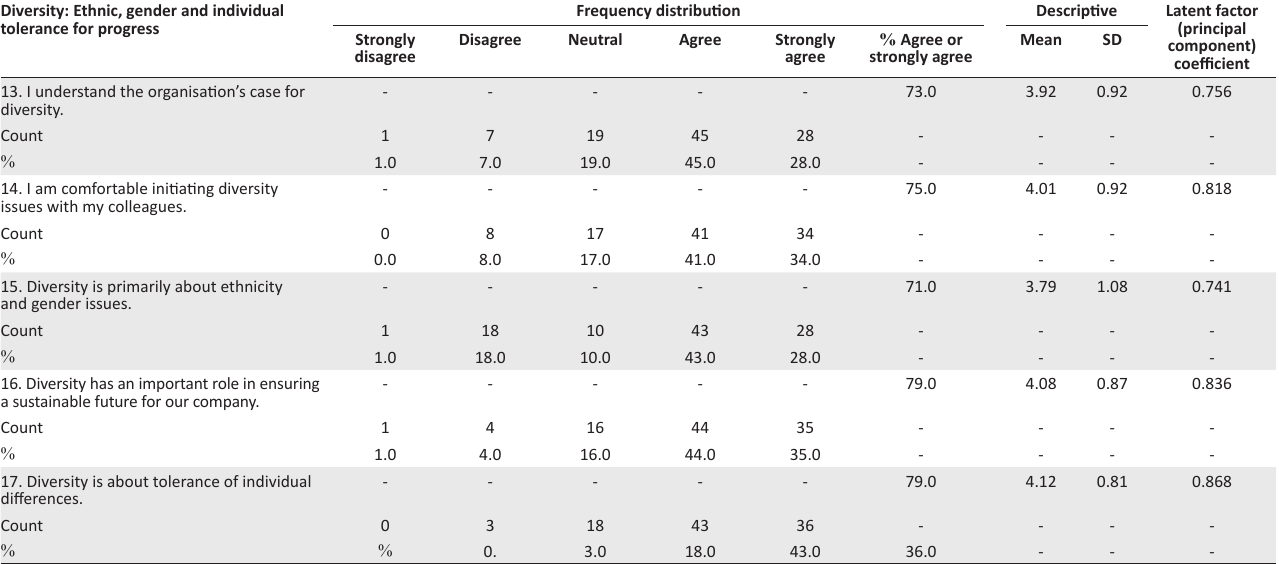
TABLE 4: Analysis of the sub-construct of ethnic, gender and individual tolerance for progress. Diversity: Ethnic, gender and individual tolerance for progress